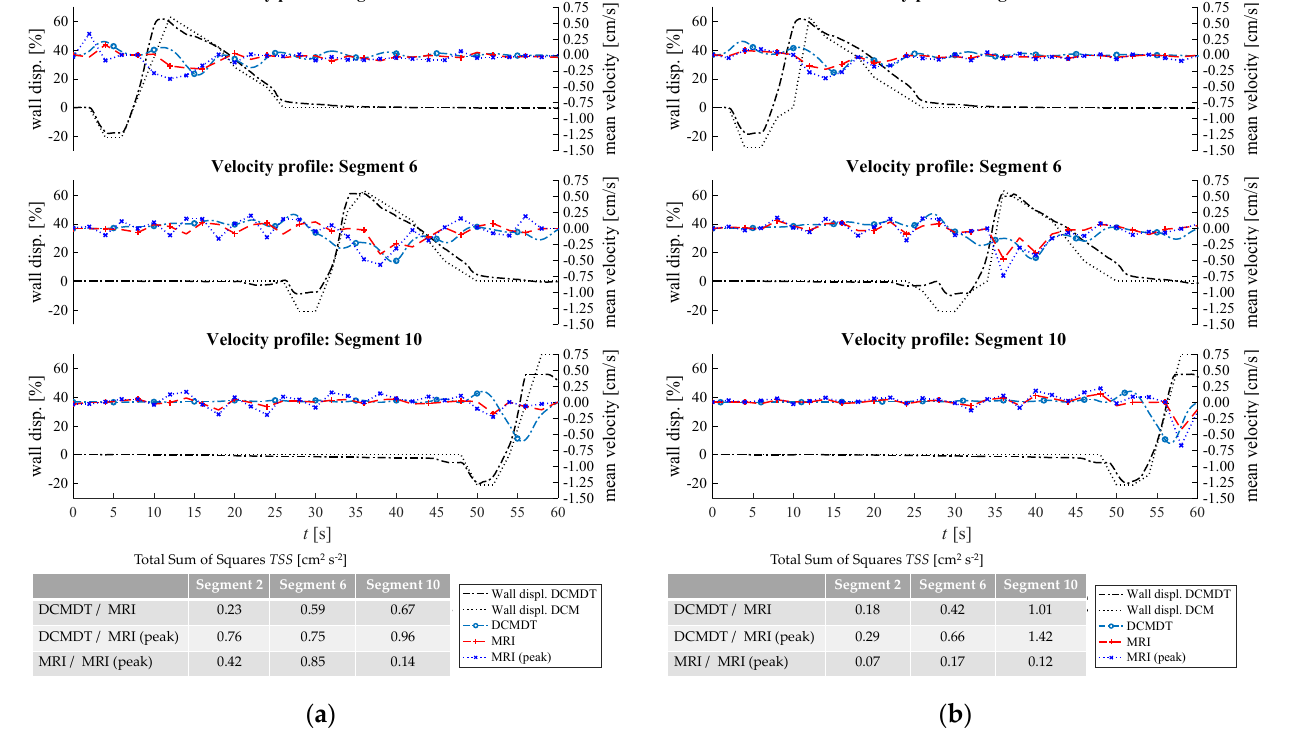
Figure 7. Comparison of the fluid velocities and wall displacement profiles of the DCM and the DCMDT with 60 % fluid volume and slower propagating PPW. Parts ( a , b ) compare the mean fluid velocities with LOVIS and HIVIS respectively.